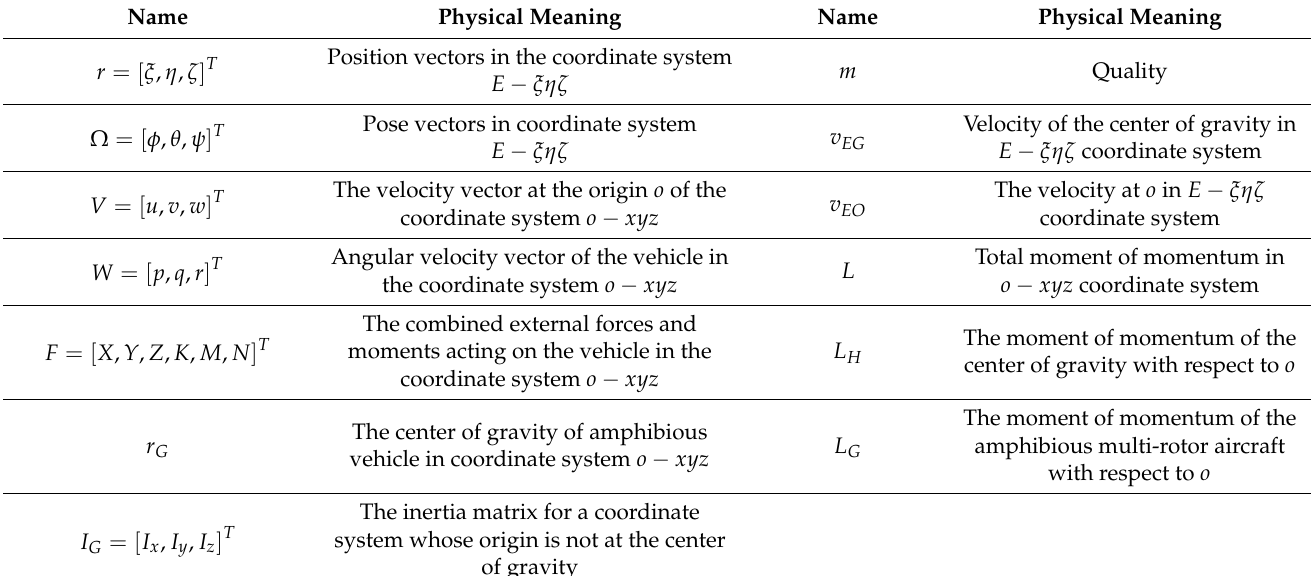
Table 1. Amphibious multi-rotor vehicle state physical